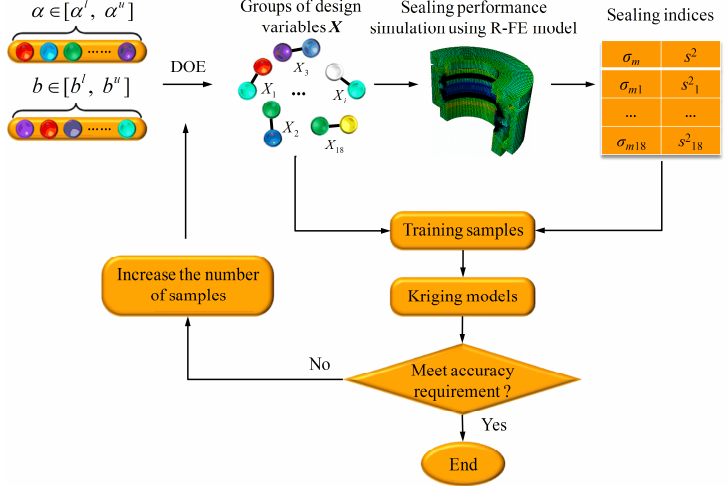
Figure 5. Construction of the sealing performance Kriging models.